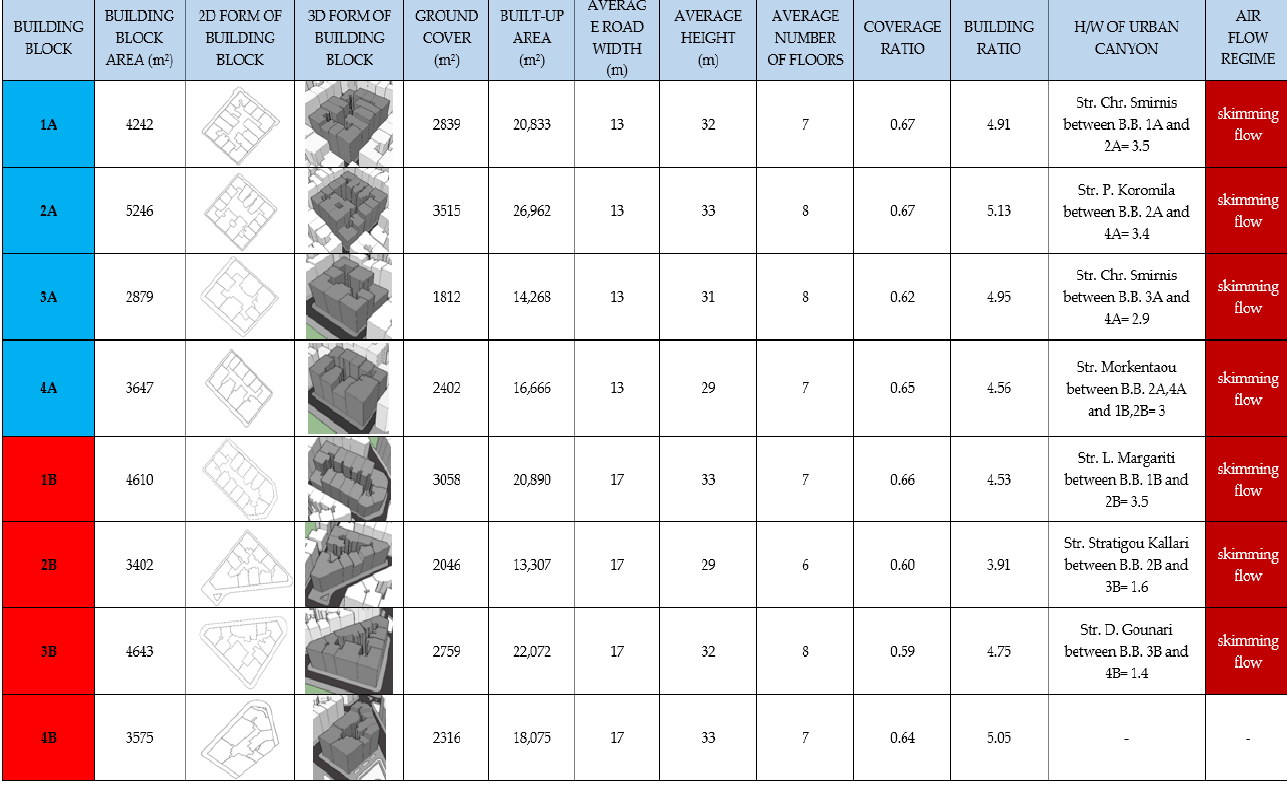
Figure 7. Typology of building blocks of the study